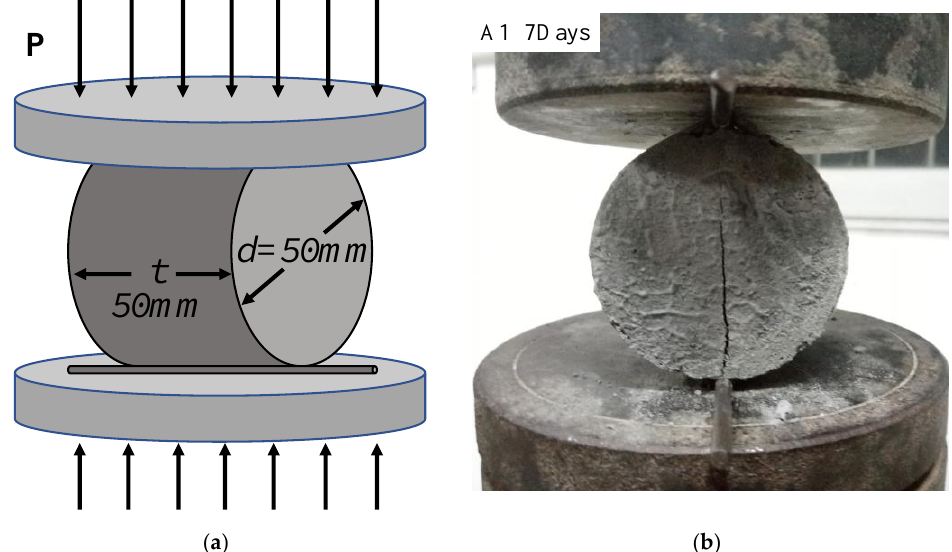
Figure 3. ( a ) The Brazilian split test. ( b ) Tensile failure of test specimen A1 curing for 28 days.